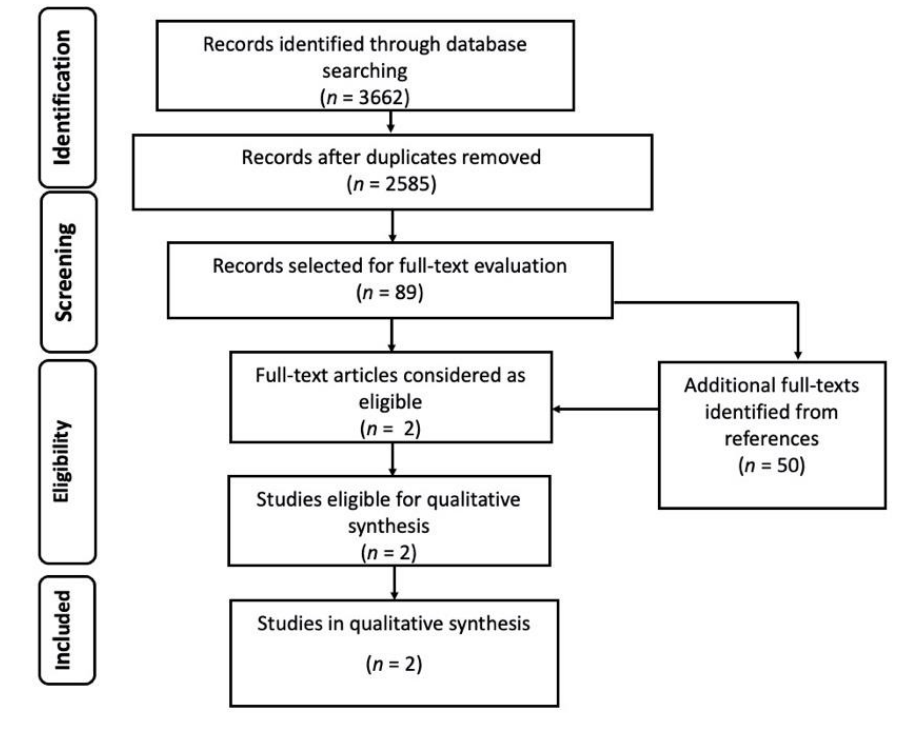
Figure 1. Flow diagram of the study selection process for Pneumocystis jirovecii pneumonia (PJP). The risk of bias in the included studies is reported in Figure 2. One study had <3 points and the other had 3 points in the FUNDICU quality scoring